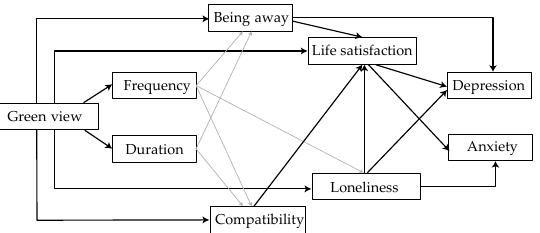
Figure 1. Conceptual framework of green view through a window: Depression and Anxiety. Note: Line widths represent the hypothesized pathway strength, with thicker lines denoting potentially stronger associations.